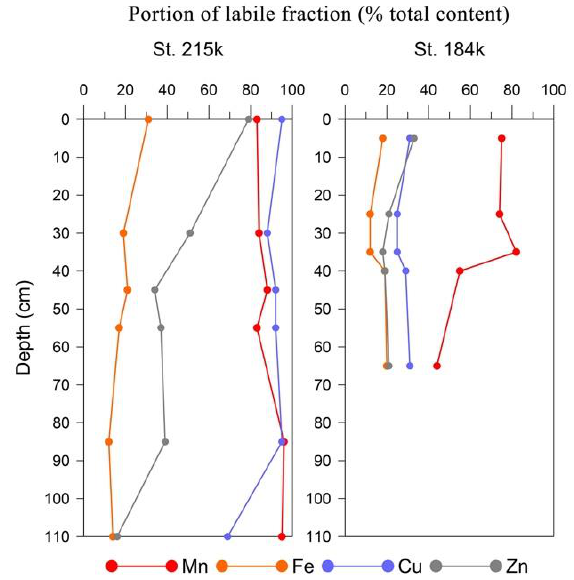
Figure 6. The down-core distribution of the labile fractions’ sum (F-1 + F-2 + F-3) of Cu, Zn, Fe, and Mn, in the ore-bearing 184k and background 215k sediment cores.